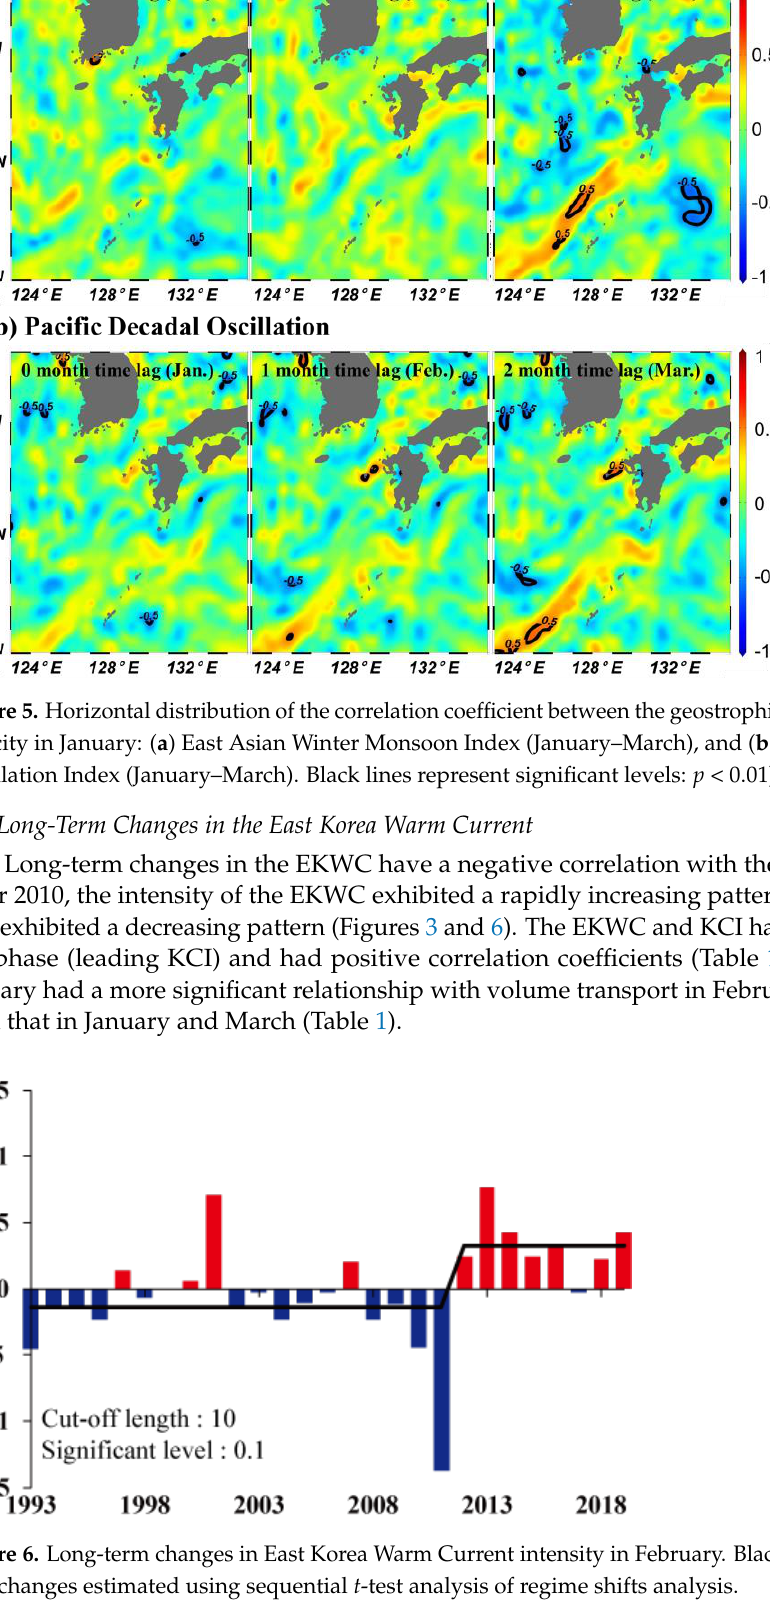
Figure 4. Horizontal distribution of the correlation coefficient between the geostrophic surface cur- rent velocity in January and the longitudinal shift of the Kuroshio Current Index in January. Black lines represent significant levels: p < 0.01.